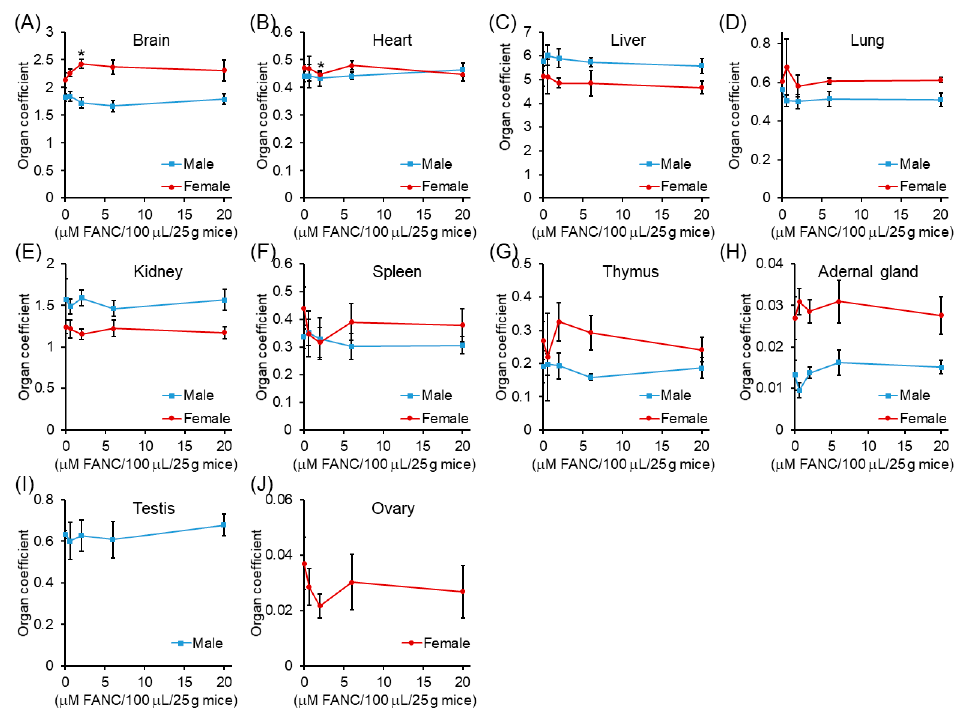
Figure 5. Organ coefficient changes of ICR mice with daily feeding of FANC for 14 days. Organ coefficient = (organ weight/body weight) × 100. Data are expressed as the mean ± SD ( n = 5).